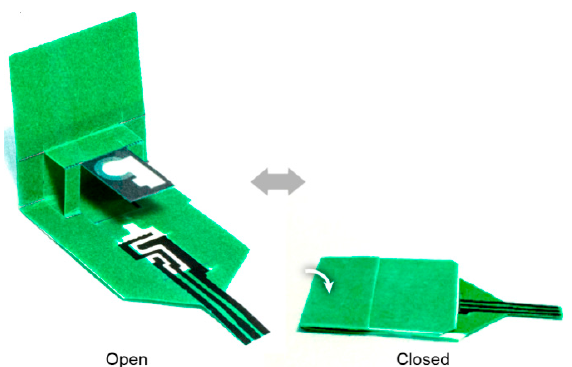
Figure 2. Pop-up paper-based sensor fabricated by Wan et al. for determination of BHB levels. Reproduced with permission from [23], Copyright American Chemical Society, 2017.